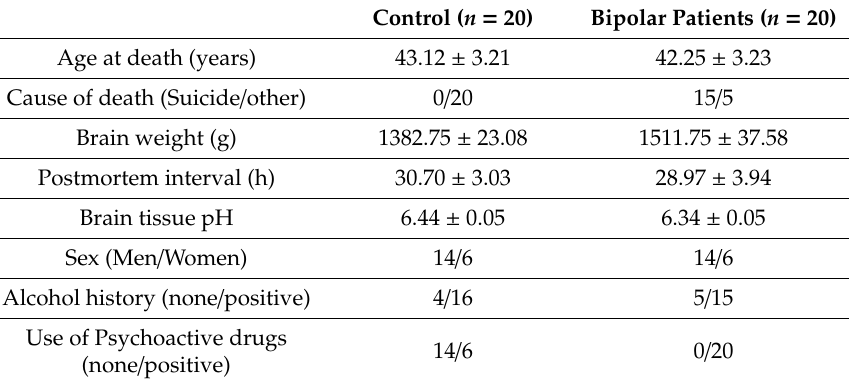
Table 1. Characteristics of BD patients and una ff ected